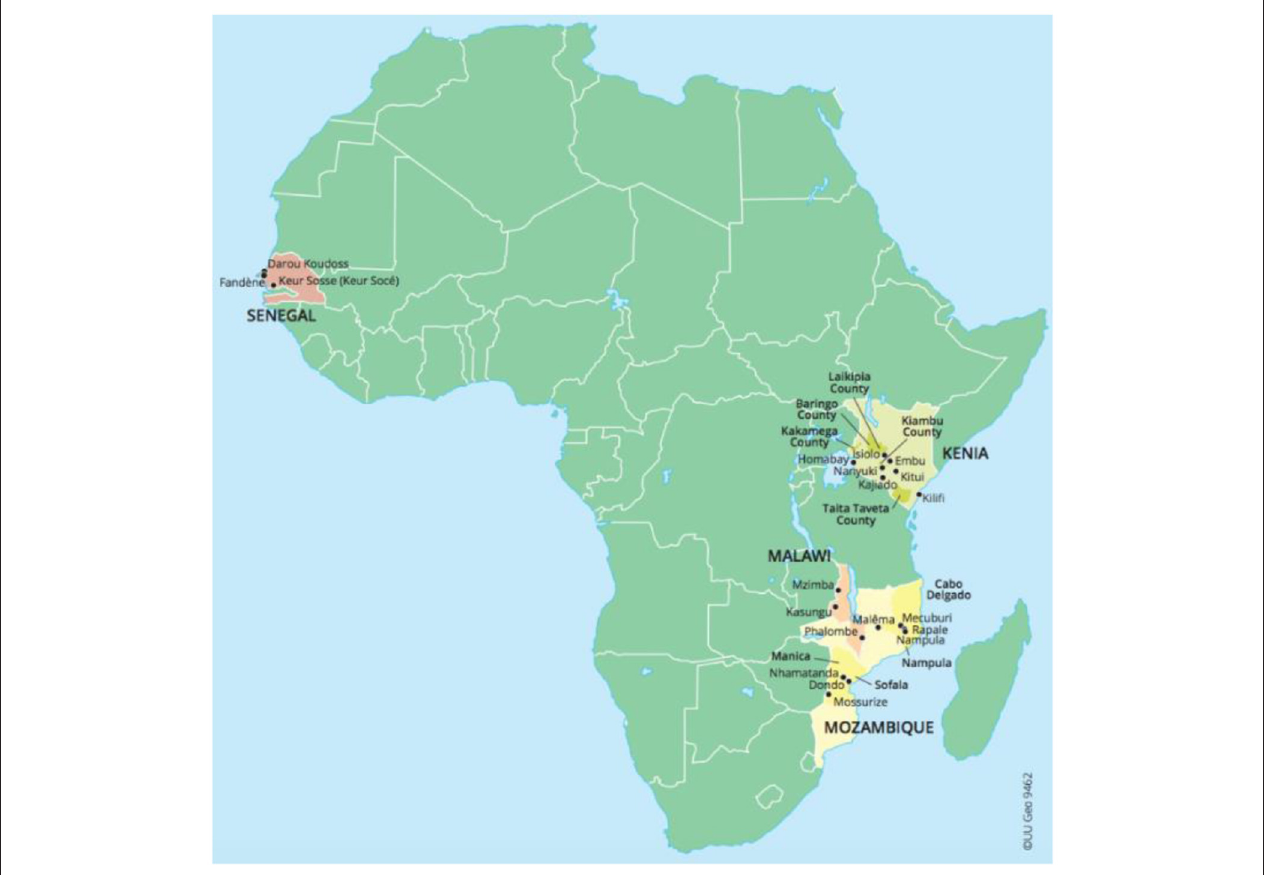
FIGURE 1 | Map of focus countries and research